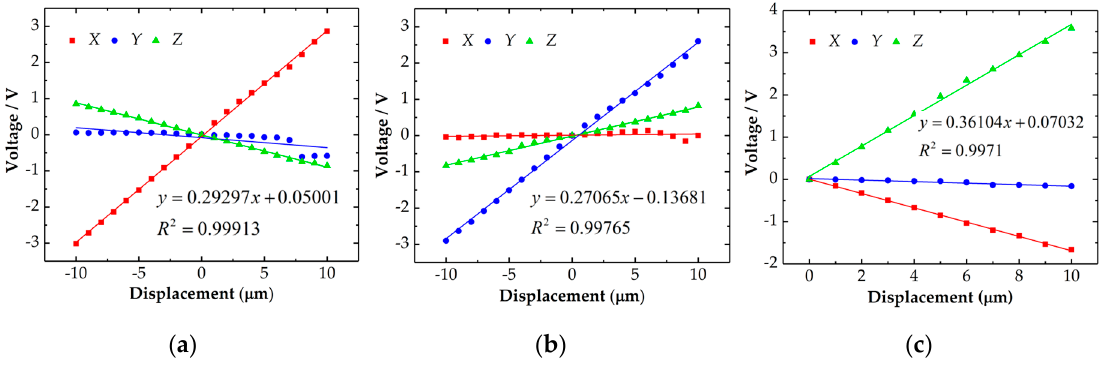
Figure 14. Test results of the probe in X ( a ), Y ( b ) and Z ( c ) direction.